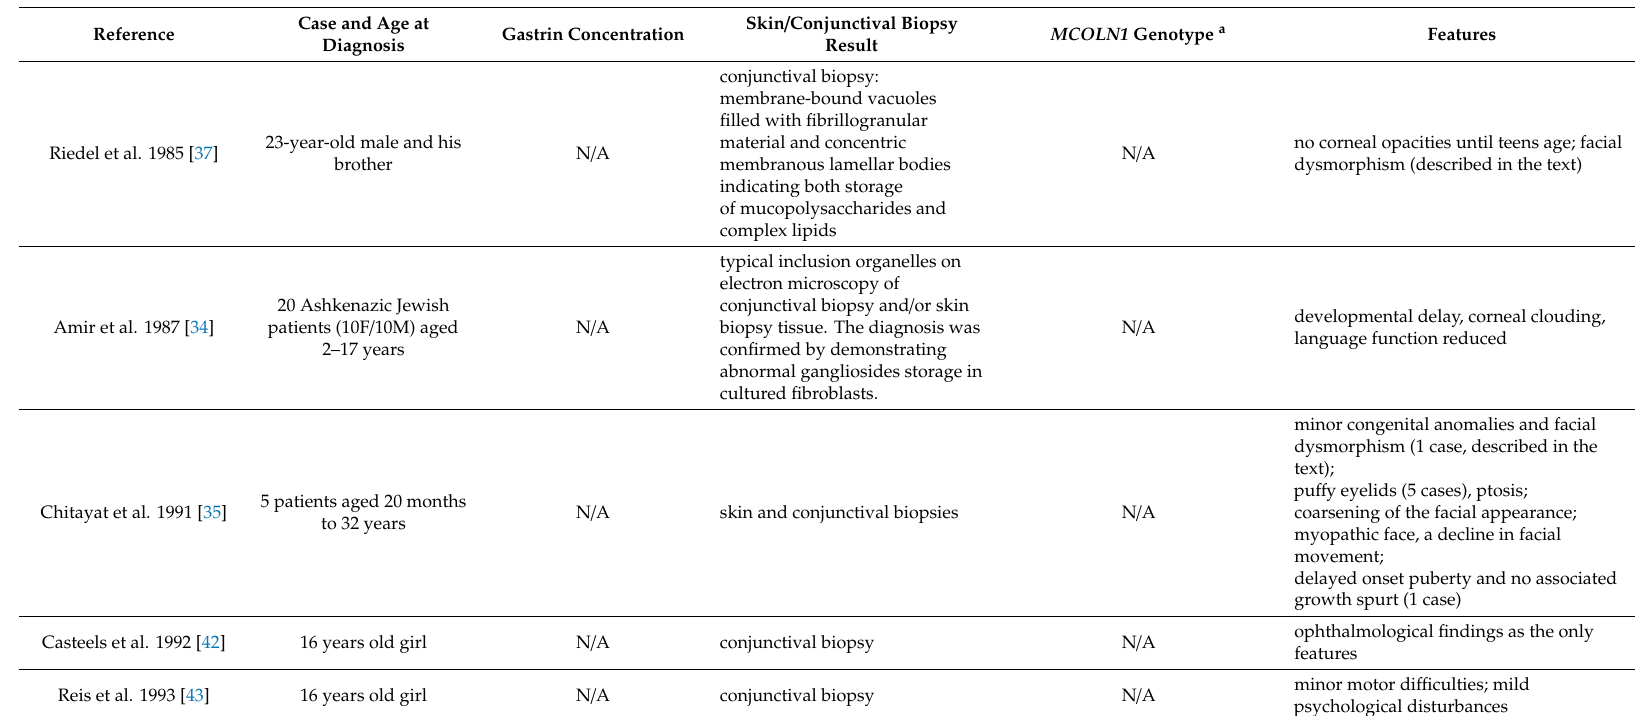
Table 1. Reports of mild or atypical manifestation of